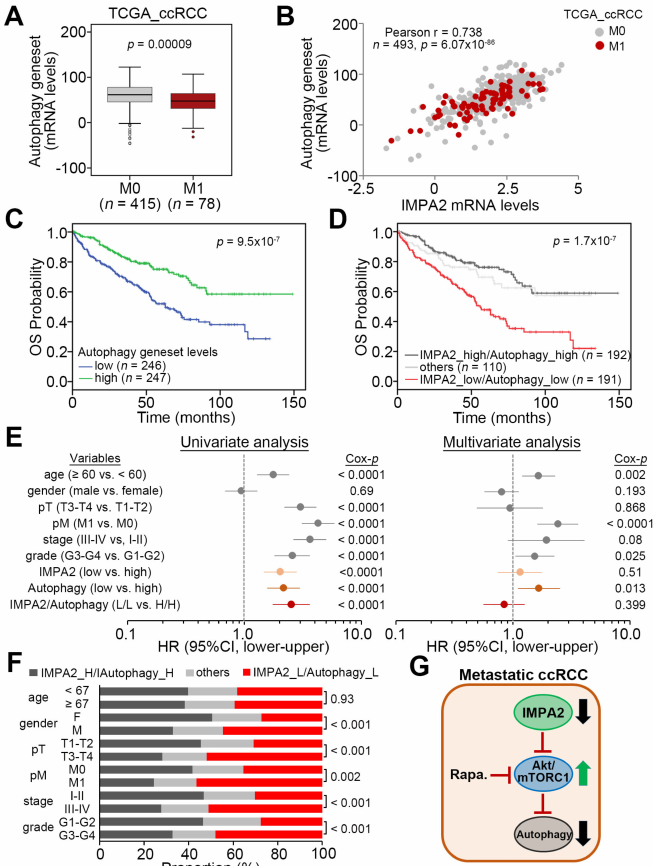
Figure 6. IMPA2 downregulation combined with a reduced autophagy activity correlates with a worse prognosis in ccRCC patients. ( A ) Boxplot for the mRNA levels of autophagy gene set in TCGA ccRCC with pathologic M0 or M1 stage. The band inside the box is the second quartile (the median). The upper and lower lines of the box are the third and first quartiles, respectively. Box plots have lines extending vertically from the whiskers indicating minimum and maximum of all of the data. The individual points indicate outliers. The significant difference was analyzed by an independent sample t -test. ( B ) Scatchard plot for IMPA2 and autophagy gene set mRNA levels from the TCGA ccRCC database. Pearson’s correlation test was used to determine the statistical significance of IMPA2 and autophagy gene set co-expression in TCGA ccRCC with pathologic M0 or M1 stage. ( C and D ) Kaplan–Meier analyses for autophagy gene set mRNA levels ( C ) or IMPA2 and autophagy gene set mRNA levels ( D ) in TCGA ccRCC patients. The high and low expression levels of IMPA2 and autophagy gene set were determined by the median of their mRNA levels in primary tumors from the TCGA ccRCC database. ( E ) Cox regression test using univariable (left) and multivariable (right) modes for IMPA2, (low vs. high), autophagy gene set (low vs. high) and IMPA2 / autophagy gene set (low / low vs. high / high) mRNA levels and other pathological variables including age (median = 60 years, elder vs. younger), gender (male vs. female), pathologic T (pT, T1 / T2 vs. T3 / T4), pM (M1 vs. M0), stage (III / IV vs. I / II) and grade (III / IV vs. I / II) under the condition of overall survival probability for 493 ccRCC patients from the TCGA database. ( F ) Chi-square test for the combined signature of IMPA2 and autophagy gene set mRNA levels and pathologic variables including age, gender, pT, pM, stage and grade from the TCGA ccRCC database. The high (H) and low (L) expression levels of IMPA2 and autophagy gene set are presented as the signatures IMPA2_H / Autophagy_H, others (IMPA2_H / Autophagy_L and IMPA2_L / Autophagy_H) and IMPA2_L / Autophagy_L. ( G ) Proposed pathway for the IMPA2 downregulation-triggered activation of Akt / mTORC1 and inhibition of autophagy initiation in metastatic ccRCC and a therapeutic value of targeting mTORC1 by its inhibitors, e.g. Rapamycin (Rapa.), to combat metastatic ccRCC with IMPA2